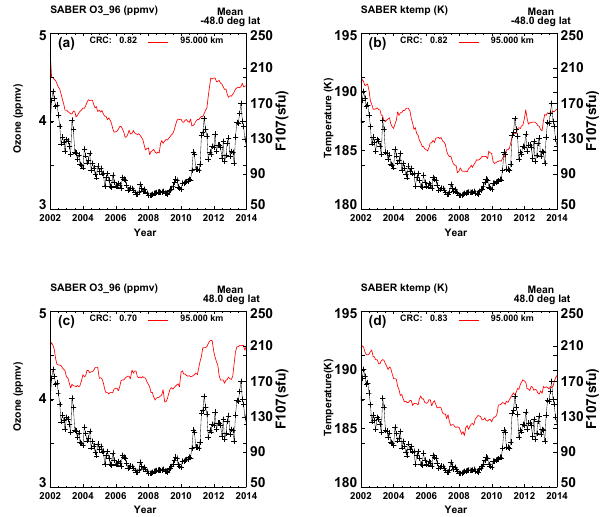
Figure 2. Top row: ozone zonal mean mixing ratios (left panel, red line) from mid-2002 to mid-2014, 95km, 48 ◦ S lat; right panel, as in left panel but for temperature. Lower row: as in top row but at 48 ◦ N lat. Black lines ( + ) show the corresponding monthly 10.7cm flux (sfu) provided by NOAA.